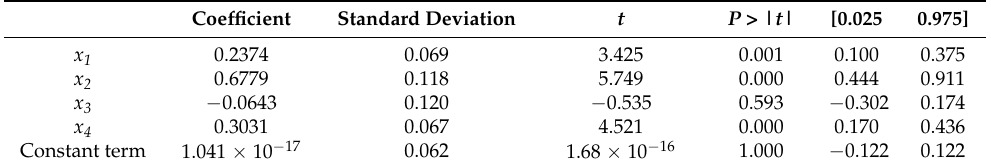
Table 3. Regression